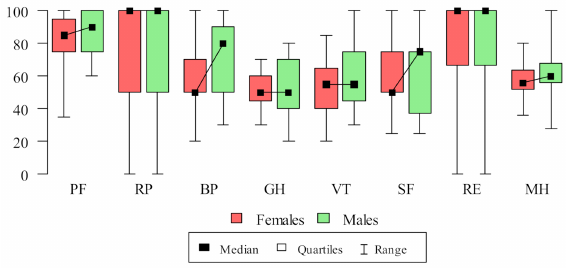
Figure 1. Differences between SF-36 domains between